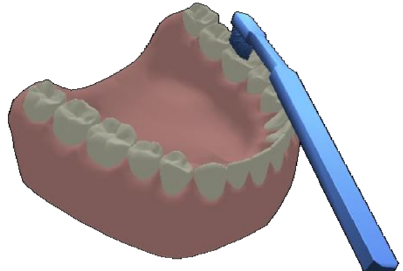
Fig. 4. Models in game prototype: gum, teeth and toothbrush.